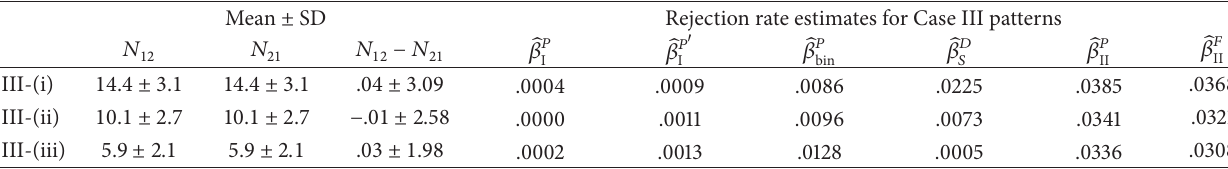
Table 9: The means ( ± SD) of the off-diagonal entries, 𝑁 12 , 𝑁 21 , and their difference 𝑁 12 − 𝑁 21 and the rejection rate estimates for Case III = 10000 , 𝑛 = 𝑛 = 40 at 𝛼 = .05 . Column labeling is as in Table 6. patterns with 𝑁 1 2 mc Mean ± SD Rejection rate estimates for Case III